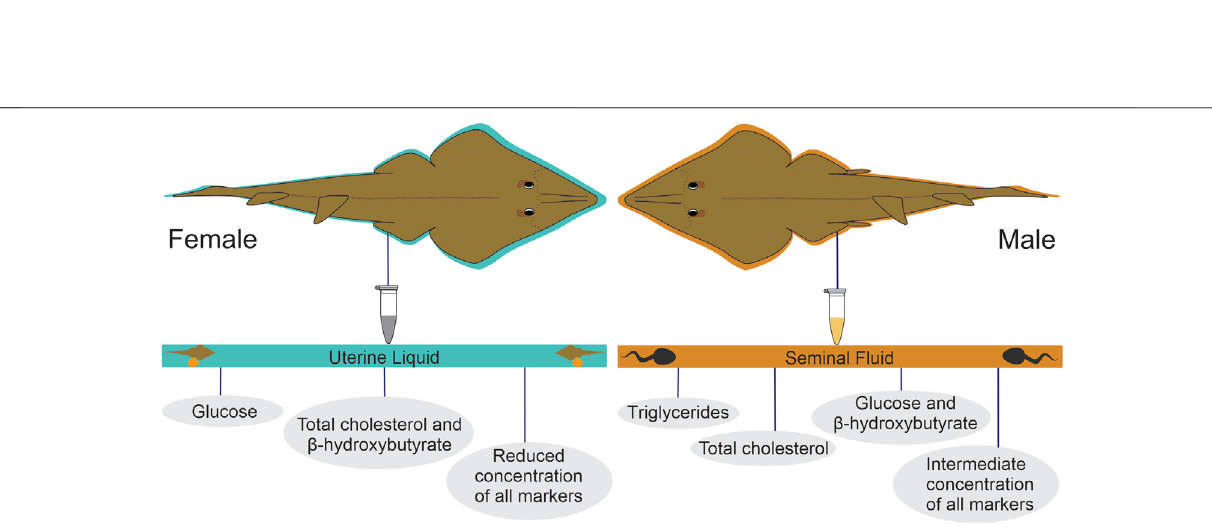
Frontiers in Physiology |